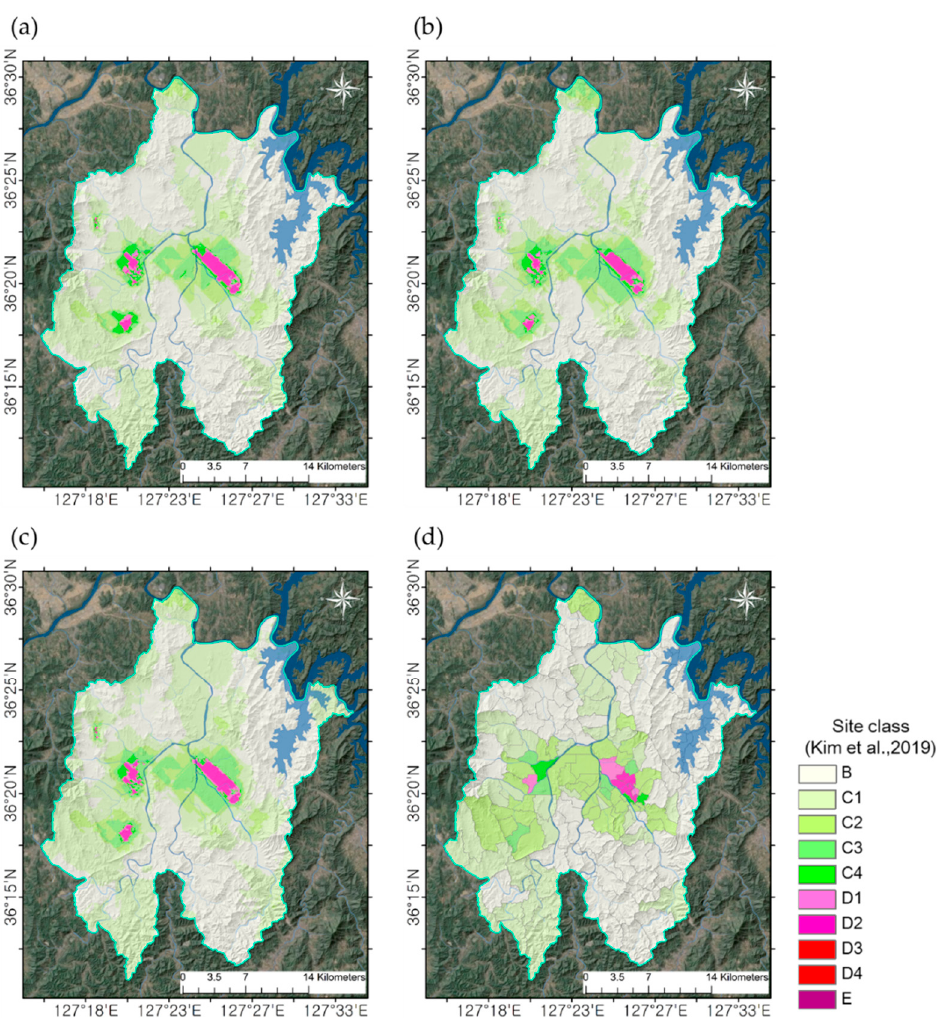
Figure 11. Maps showing the results of using principal component analyses to unify the multilayer seismic zonation for the parameter combinations shown in Table 3: ( a ) combination #1; ( b ) combination #2; and ( c ) combination #3. ( d ) Map showing the seismic zonation with administrative sub-units generated using the average principal component-based site class (Table 1) and combination #3 for each clustered mesh.